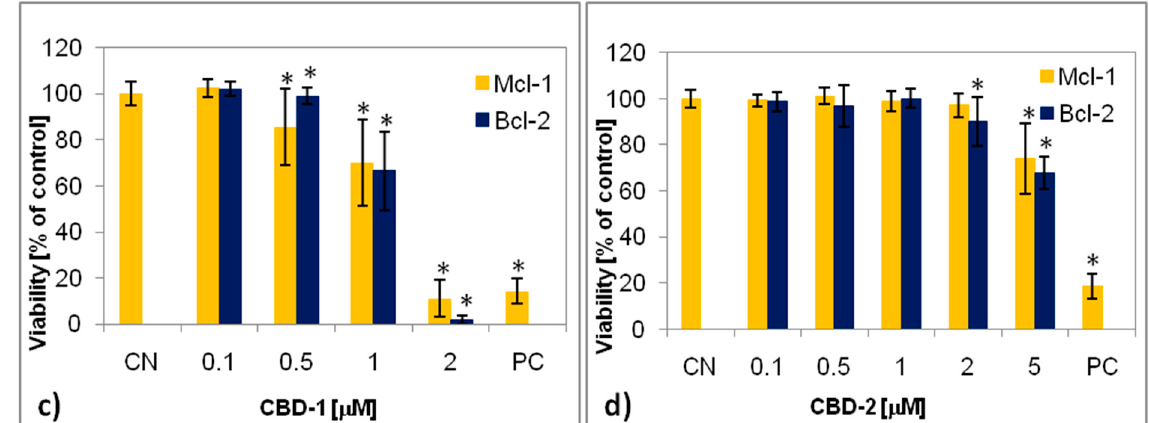
Figure 7. Viability of MCF-7 cells after 24 h exposure to dendrimers: CBD-1 ( a ) and CBD-2 ( b ) and dendriplexes ( c , d ) at different concentrations. The dendrimer/siRNA molar ratio was 20:1; * p < 0.05 compared to CN.